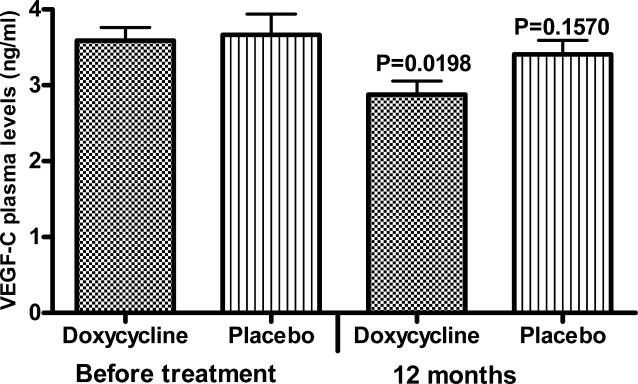
Plasma Levels of VEGF-C of Microfilaremic Patients before and 12 Mo after Doxycycline TreatmentPlasma concentrations (mean ± SD) of VEGF-C were measured from plasma of microfilaremic patients before and 12 mo after doxycycline treatment (17 doxycycline treated, 16 placebo, see Table 1). The VEGF-C levels decreased significantly at 12 mo (preceding supratesticular lymphatic dilation, see Table 2) in the doxycycline-treated patients (p = 0.0198), but no difference in the placebo group occurred (paired t-test).